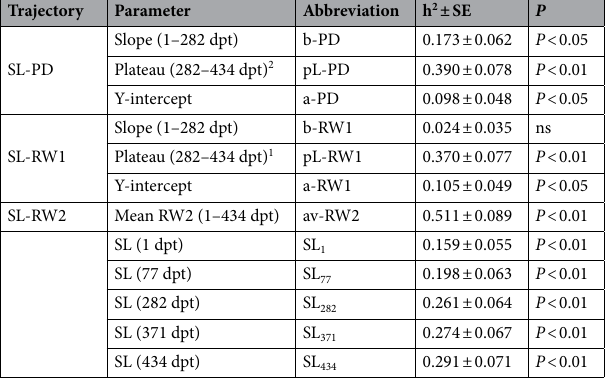
Table 1. Estimates of heritabilities (h 2 ) for body-shape trajectory traits (RW1 and PD) and fish standard length (SL). P values indicate the significance of the estimates’ difference from zero, ns not significant difference, dpt days post-tagging, PD Procrustes distance, RW 1, RW 2 scores of the 1st and 2nd relative warp axis respectively. 1, mean RW1 (282–434 dpt). 2, mean PD (282–434 dpt).